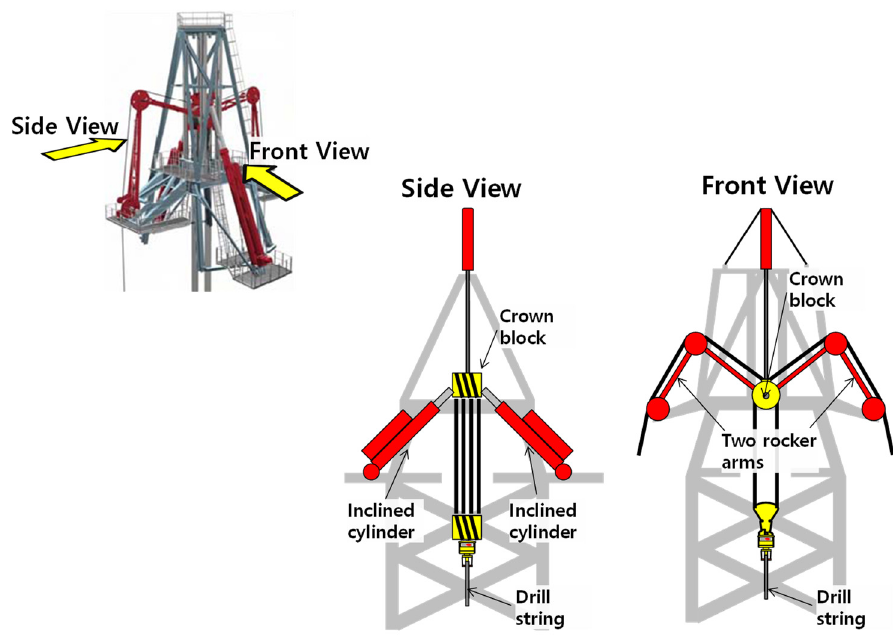
Figure 5. Side and front views of the drill string compensator.